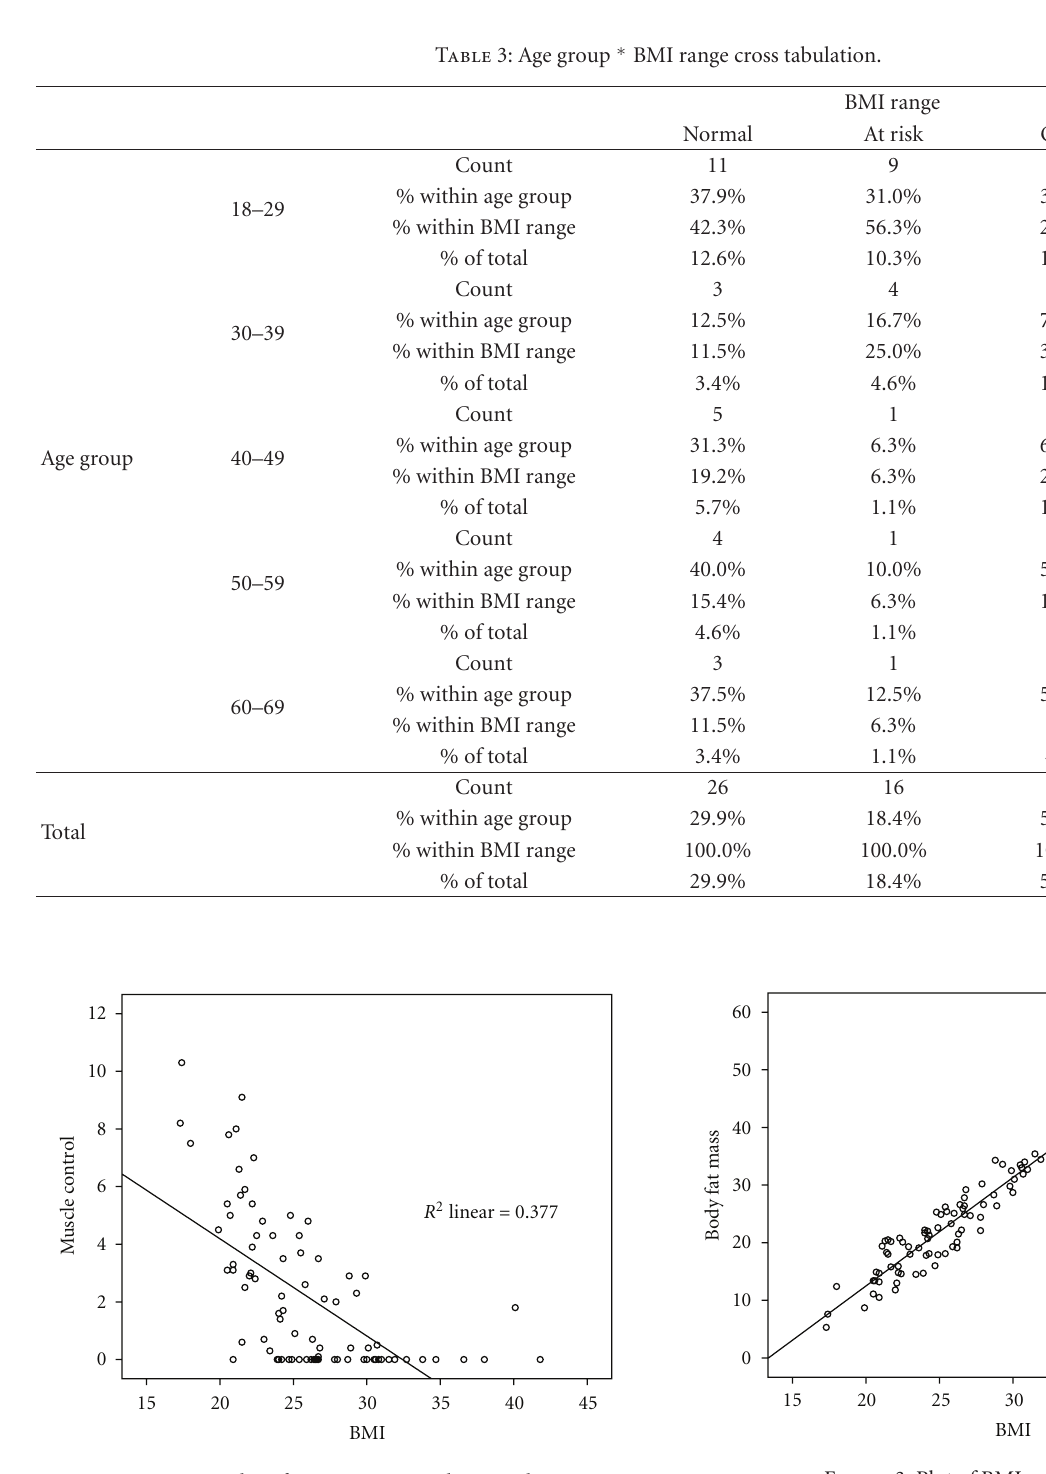
Figure 2: Plot of BMI versus muscle control. Figure 3: Plot of BMI versus